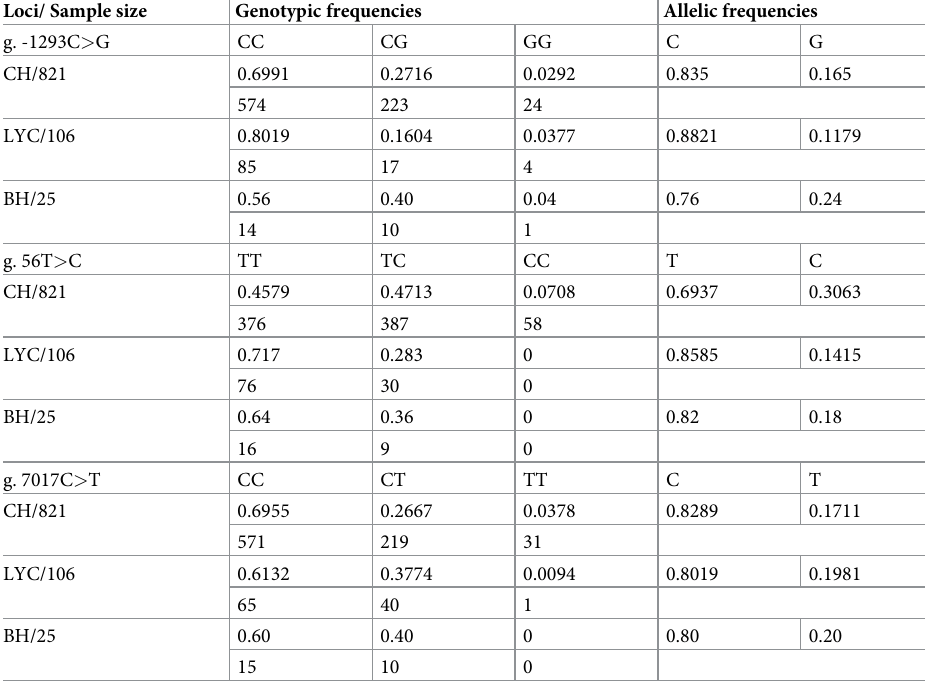
Table 3. Genotypic distribution and allelic frequencies of 3 SNPs of the bovine C3 gene of three breeds. Loci/ Sample size Genotypic frequencies Allelic